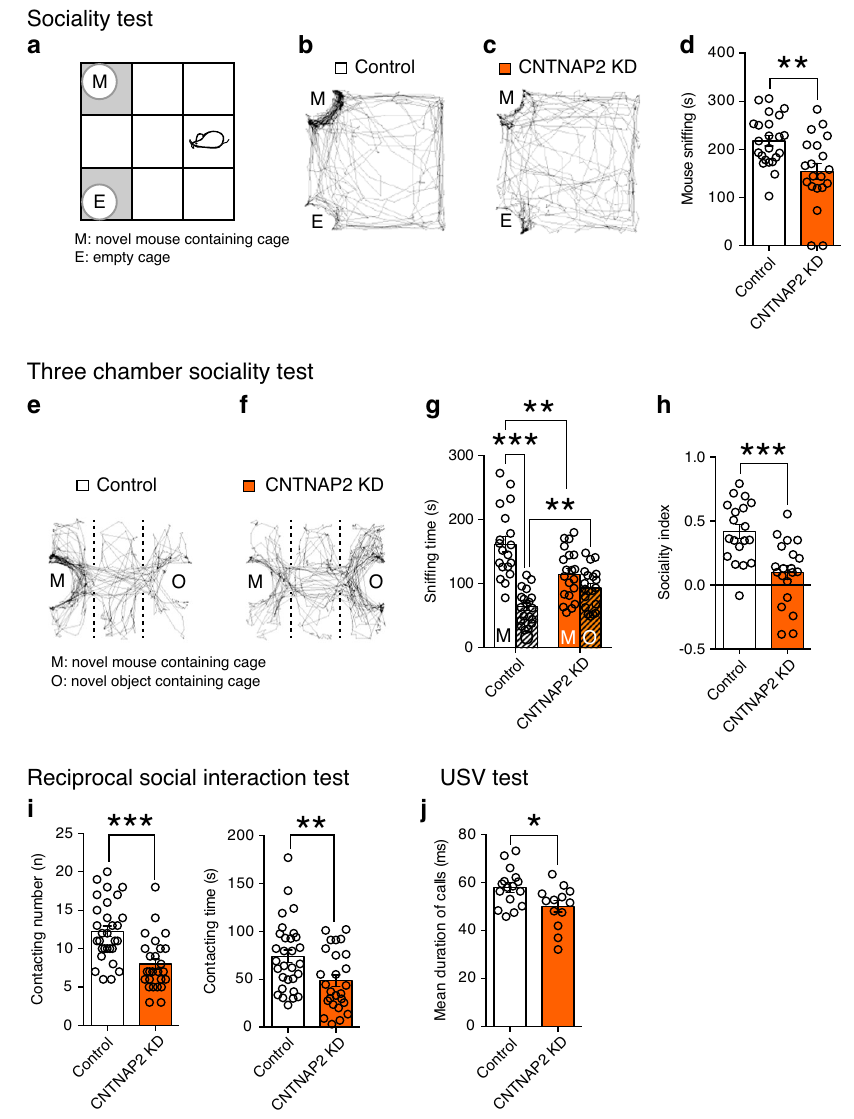
Fig. 2 Effects of CNTNAP2 knockdown in layer 2/3 pyramidal neurons of the PFC on ASD-like behaviors. a – d Schema of the sociality test ( a ). Representative tracks ( b , c ), and summary graphs showing the amount of time snif fi ng the novel mouse (M) ( d ) for CNTNAP2-scramble (control) (white columns, n = 23) and CNTNAP2-KD (orange columns, n = 20) mice. e – h Representative tracks ( e , f ) and summary graphs showing the amount of time snif fi ng the novel mouse (M) and the novel object (O) ( g ), and sociality index ( h ) for control (white columns, n = 19) and CNTNAP2-KD (orange columns, n = 20) mice. i Contacting number and time for control (white column, n = 30) and CNTNAP2-KD (orange column, n = 26) mice. j Duration of calls for control (white column, n = 16) and CNTNAP2-KD (orange column, n = 14) pups. *P < 0.05, **P < 0.01, ***P < 0.001 (Student ’ s t test or Paired t test). Data are mean ± SEM. Source data are provided as a Source Data fi